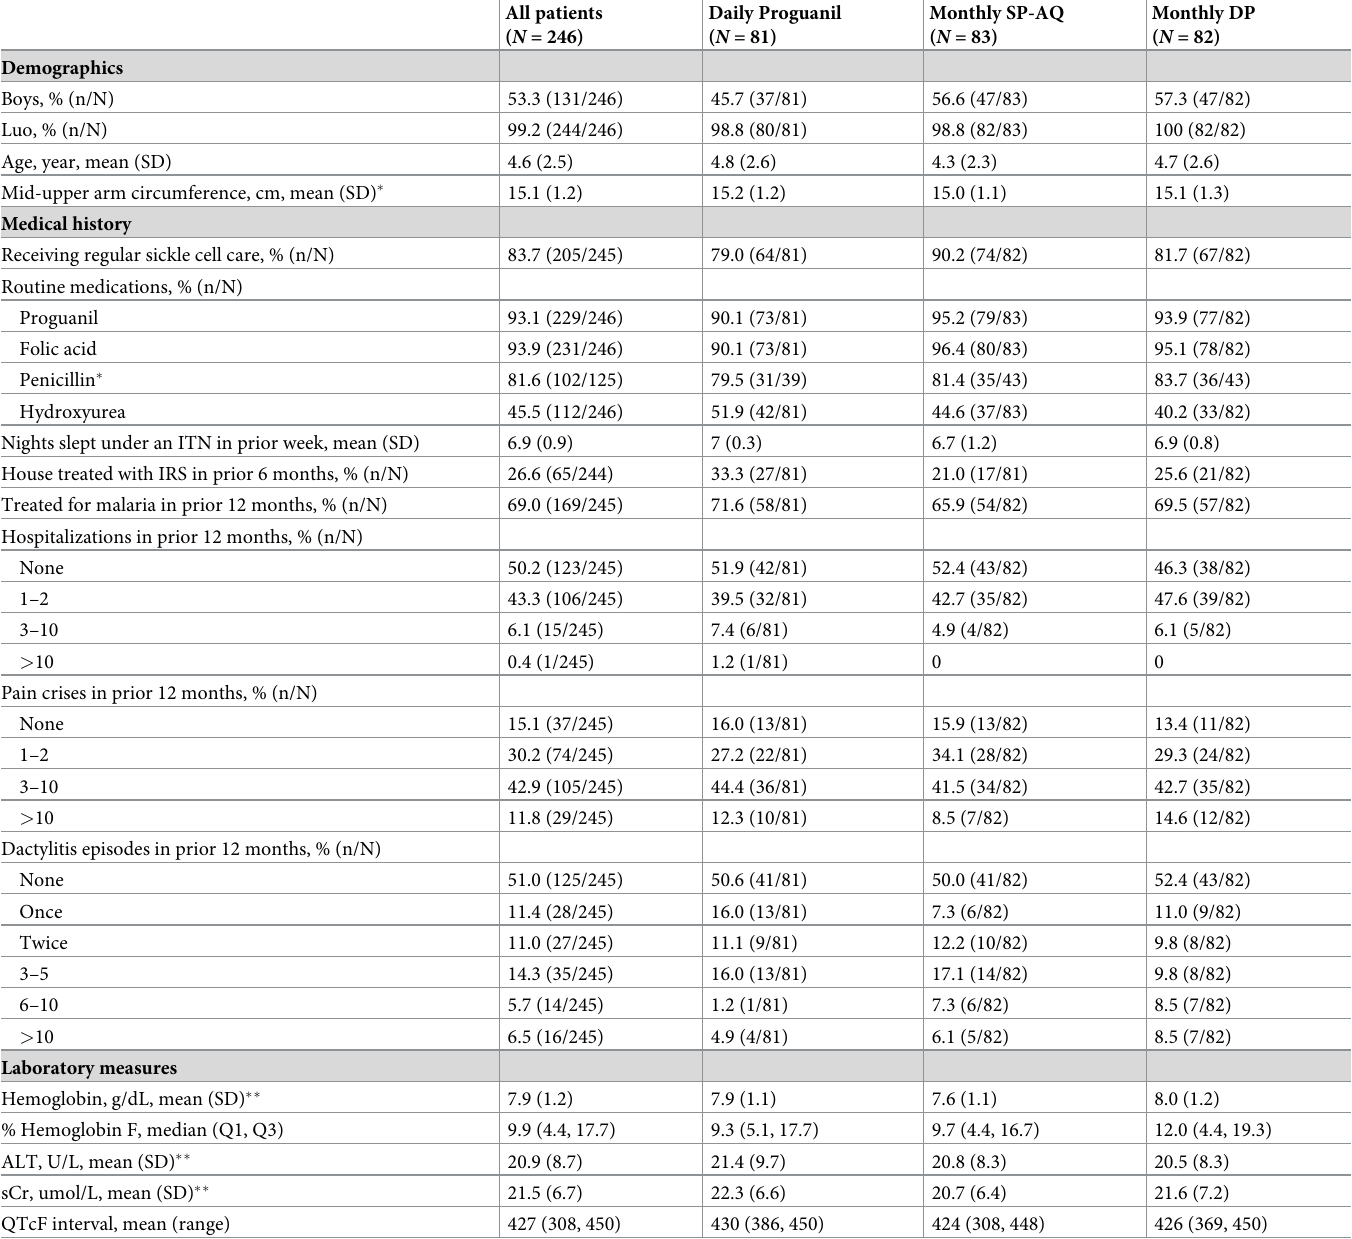
Table 1. Characteristics of the patients at